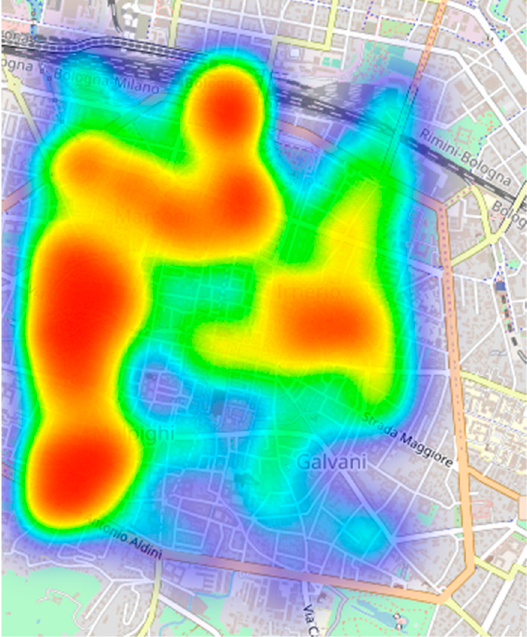
Figure 2. A graphical representation of ParticipAct data set.